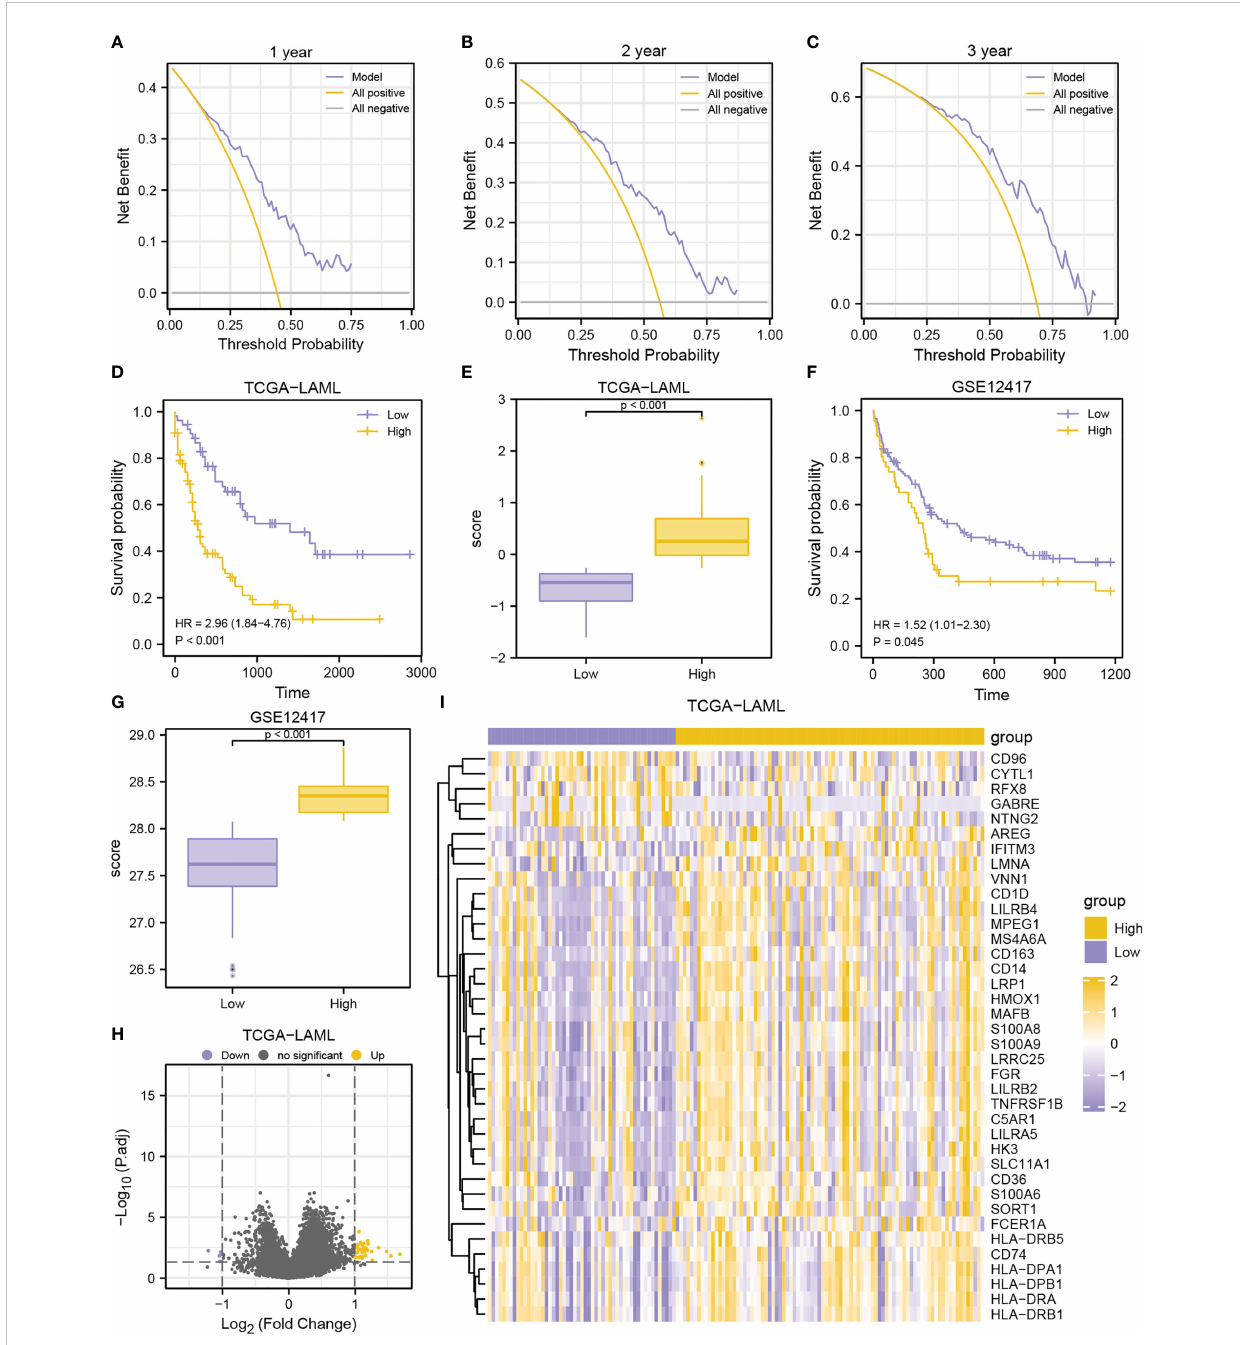
FIGURE 6 Prognostic performance of the MMRGs prognosis model. A-C. DCA curves of MMRGs prognosis model for the 1-year (A) , 2-year (B) , and 3-year (C) . D-E. Prognostic KM curves (D) and group comparison (E) in TCGA-LAML dataset. (F, G) . Prognostic KM curves (F) and group comparison (G) in GSE12417 cohort. (H, I) . Volcano plot (H) and heatmap (I) of DEGs between high- and low-risk groups in TCGA-LAML